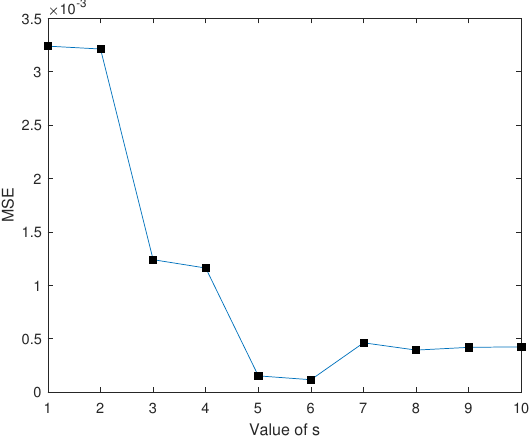
Figure 3. MSE with noiseless data after 100